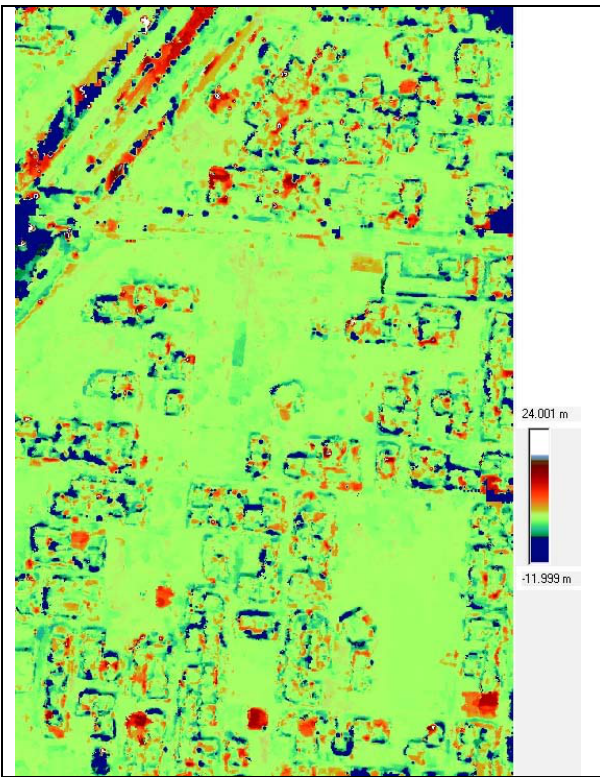
Figure 34: DSM differences – GeoEye-1 minus IKONOS